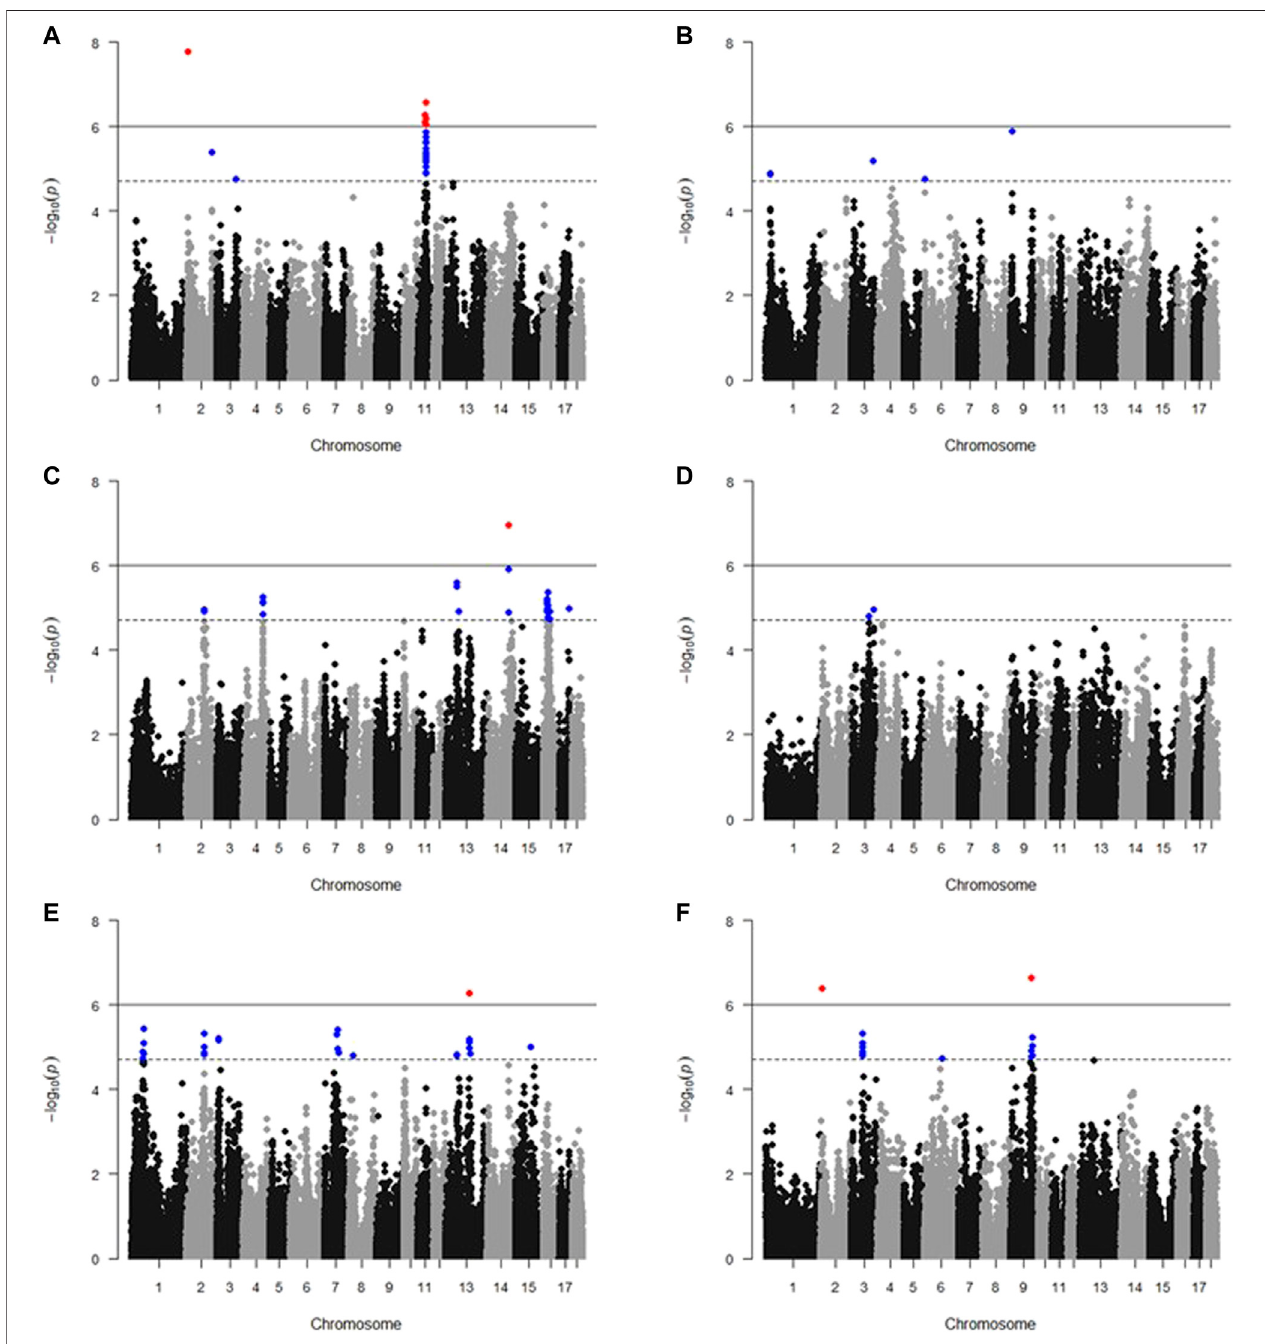
FIGURE 1 | Manhattan plots of GWAS of meat color. (A) L* 45 min; (B) L* 24 h; (C) a* 45 min; (D) a* 24 h; (E) b* 45 min; and (F) b* 24 h. The x -axis indicates the chromosome(1-18)wheretheSNPswerelocated,and y -axisdenotesthe − log10 p -value.Thegraydashed linerepresentsthesuggestivesigni fi cancethreshold (1.78* 10 − 5 ), and the gray solid line represents the genome-wide signi fi cance threshold (8.89 * 10 − 7 ). Blue dots and red dots stand for SNPs that reached the suggestive signi fi cance threshold and genome-wide signi fi cance threshold,